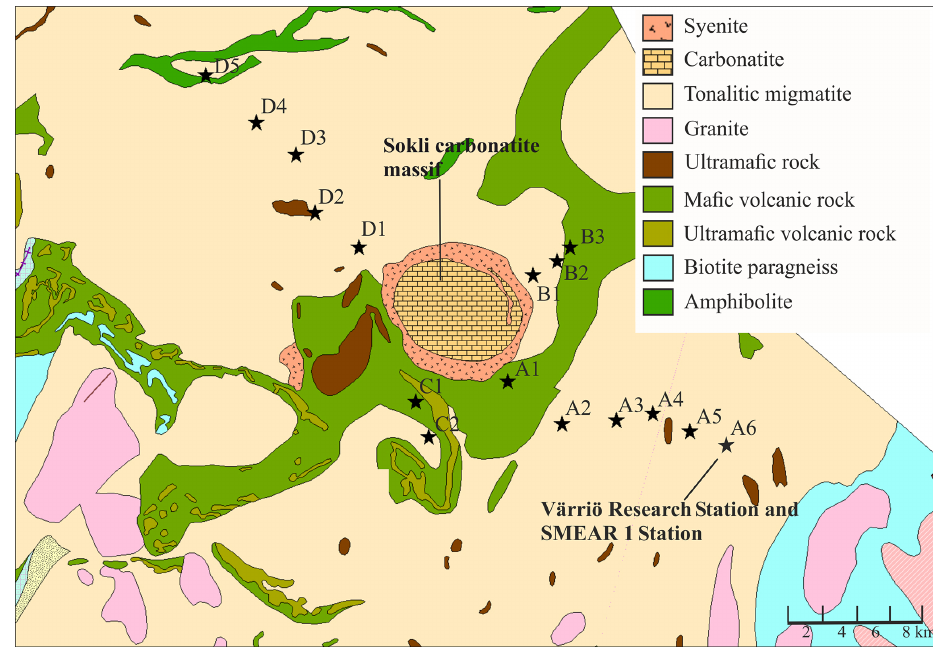
Figure 1. Geological map of the research area. Plots are marked with black stars. The easternmost plot is located at the SMEAR 1 Station. (source: Hakku Service, https://hakku.gtk.fi/en/locations/search, last access: 28 February